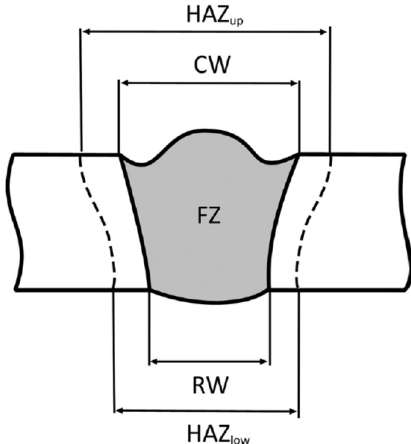
Figure 4. Geometric features employed for weld bead characterization.